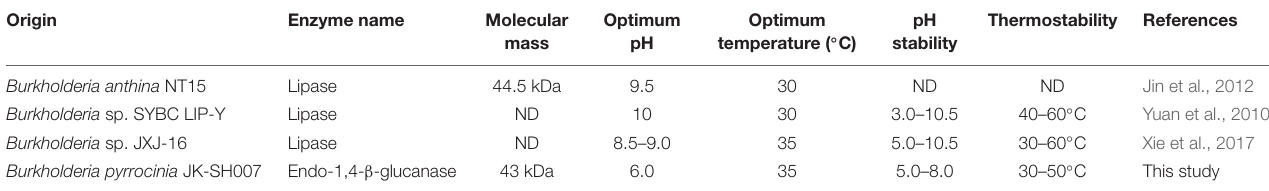
TABLE 3 | Properties of cold-active enzymes from Burkholderia